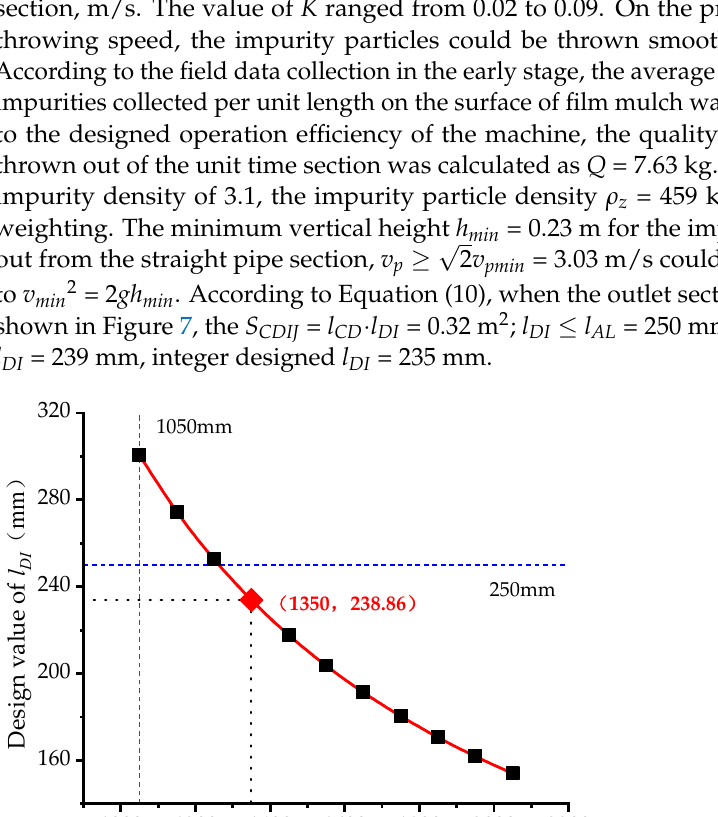
Figure 8. Design scheme of the throwing arc segment. According to the kinematics equation:     